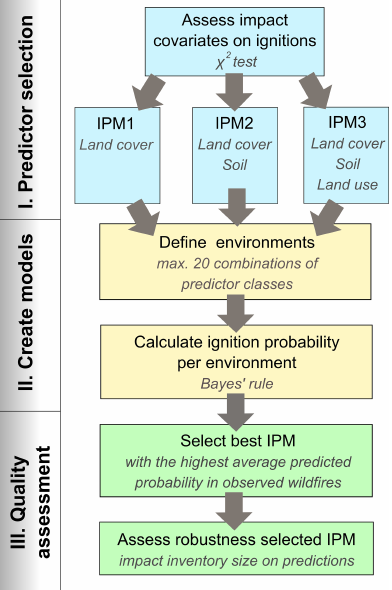
Figure 2. A schematic representation of the methodology used in this paper to calculate the wildfire ignition probability. In stage I, we assess the significance of the impact on wildfire ignition of the three predictors, and we outline three models, each with a different parameter set. In stage II, no more than 20 unique environments are created per model through the combination of different predictor classes. We then use Bayes’ rule to calculate the ignition probability observed in each environment. Stage III comprises the selection of the best model and assessing its robustness, or, in other words, the impact of the inventory size on the model’s prediction average and